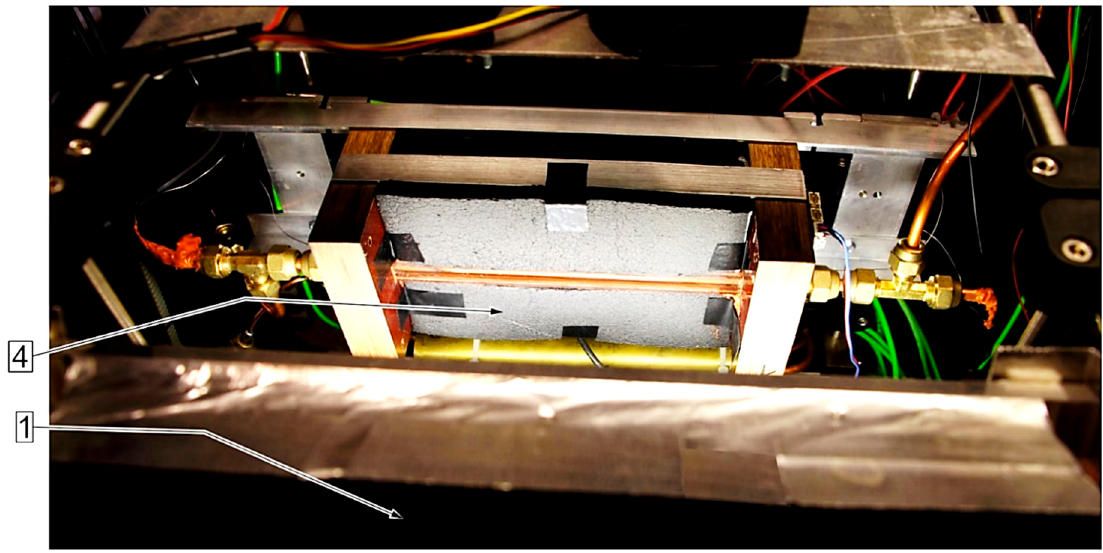
Figure 5. View of the measurement module with the mini-channel; labels as in Figure 4.